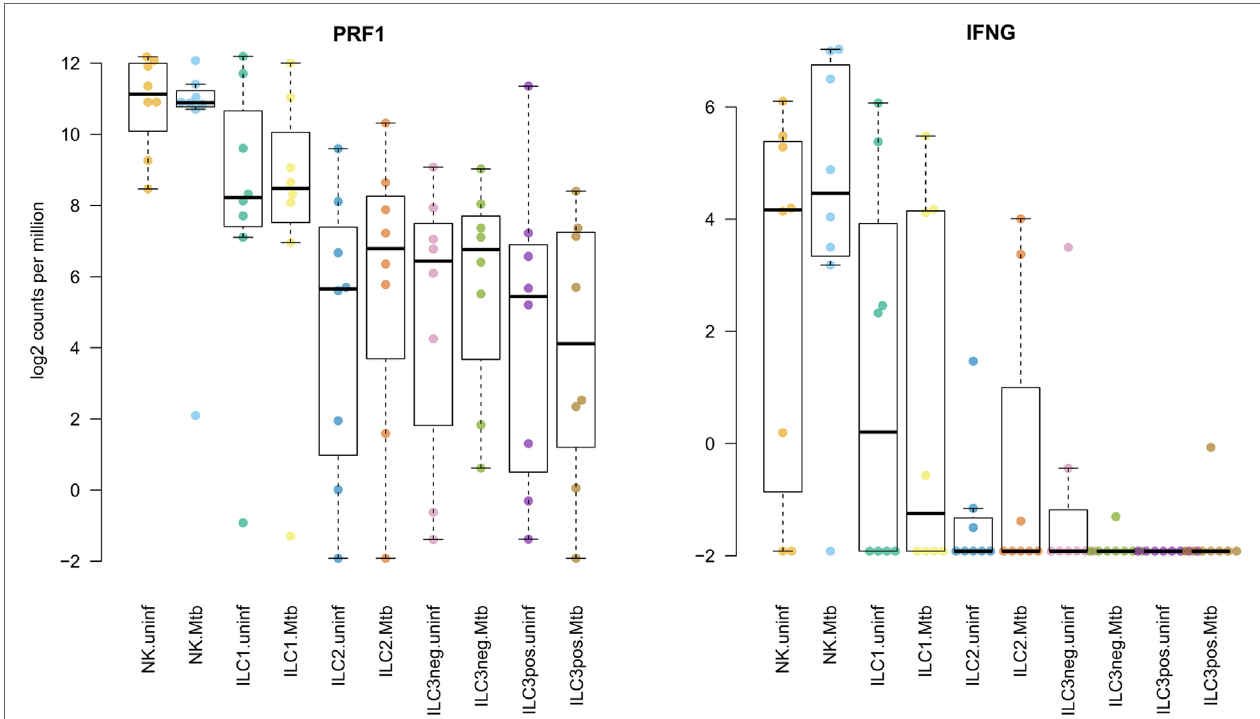
FigUre 6 | Induction of regulatory cytokines in innate lymphoid cells in human lung tissue upon Mycobacterium tuberculosis (Mtb) stimulation. Plotted are log2 read counts per million sequenced reads from isolated cells for each donor tissue sample. Boxplots show median plus first and third quartile; whiskers extend to the most outer data point within 1.5 times the interquartile